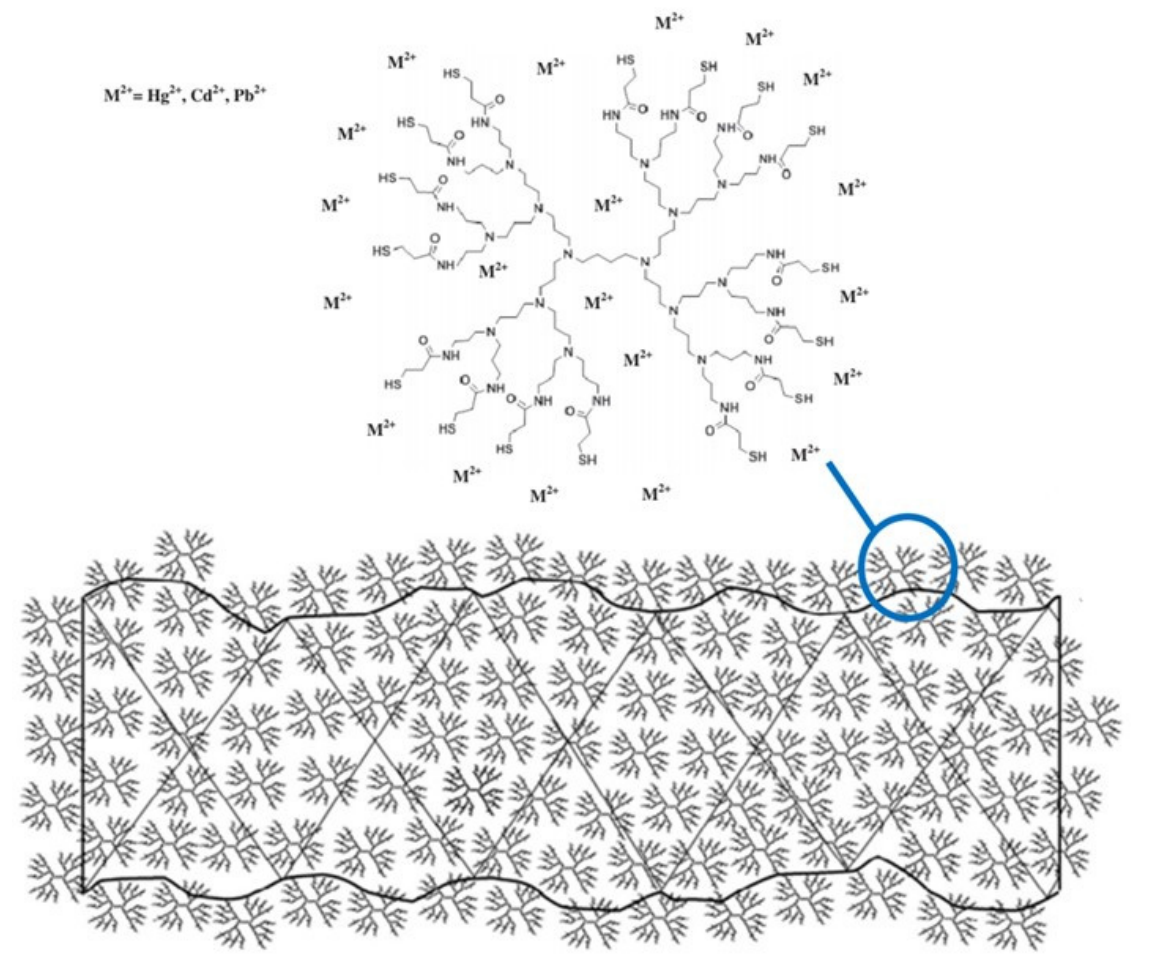
Figure 12. Schematic representation of the coated regenerated cellulose membrane by DAB-3-(SH)16 dendrimer. The detail ( top , right ) illustrates the dendrimer’s ability to adsorb cations. Adapted with permission from [149], copyright of Elsevier.